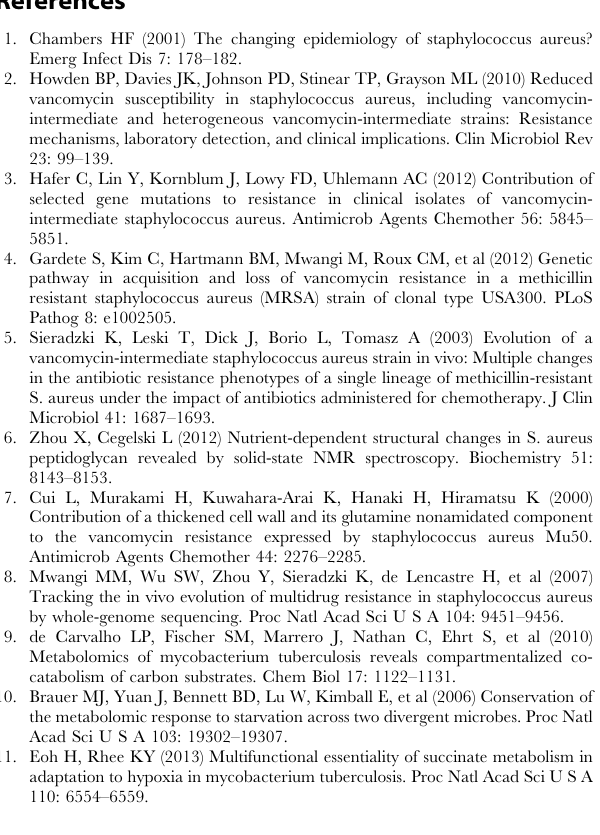
Table S3 Characteristics and ‘‘raw’’ (biomass-adjusted and normalized to baseline) ion counts of the 164 ‘‘core’’ metabolites (including 72 identified) in isolates SG-S, SG-R and SG-rev. Superscript ( a ) denotes Retention Time (RT), ( b ) denotes Positive Mode (POS) versus Negative Mode (NEG), ( c ) denotes Molecular Feature Extraction (MFE), which extracts chromatographic peaks by molecular features versus Find by Formula (FBF) which extracts peaks by chemical formula.